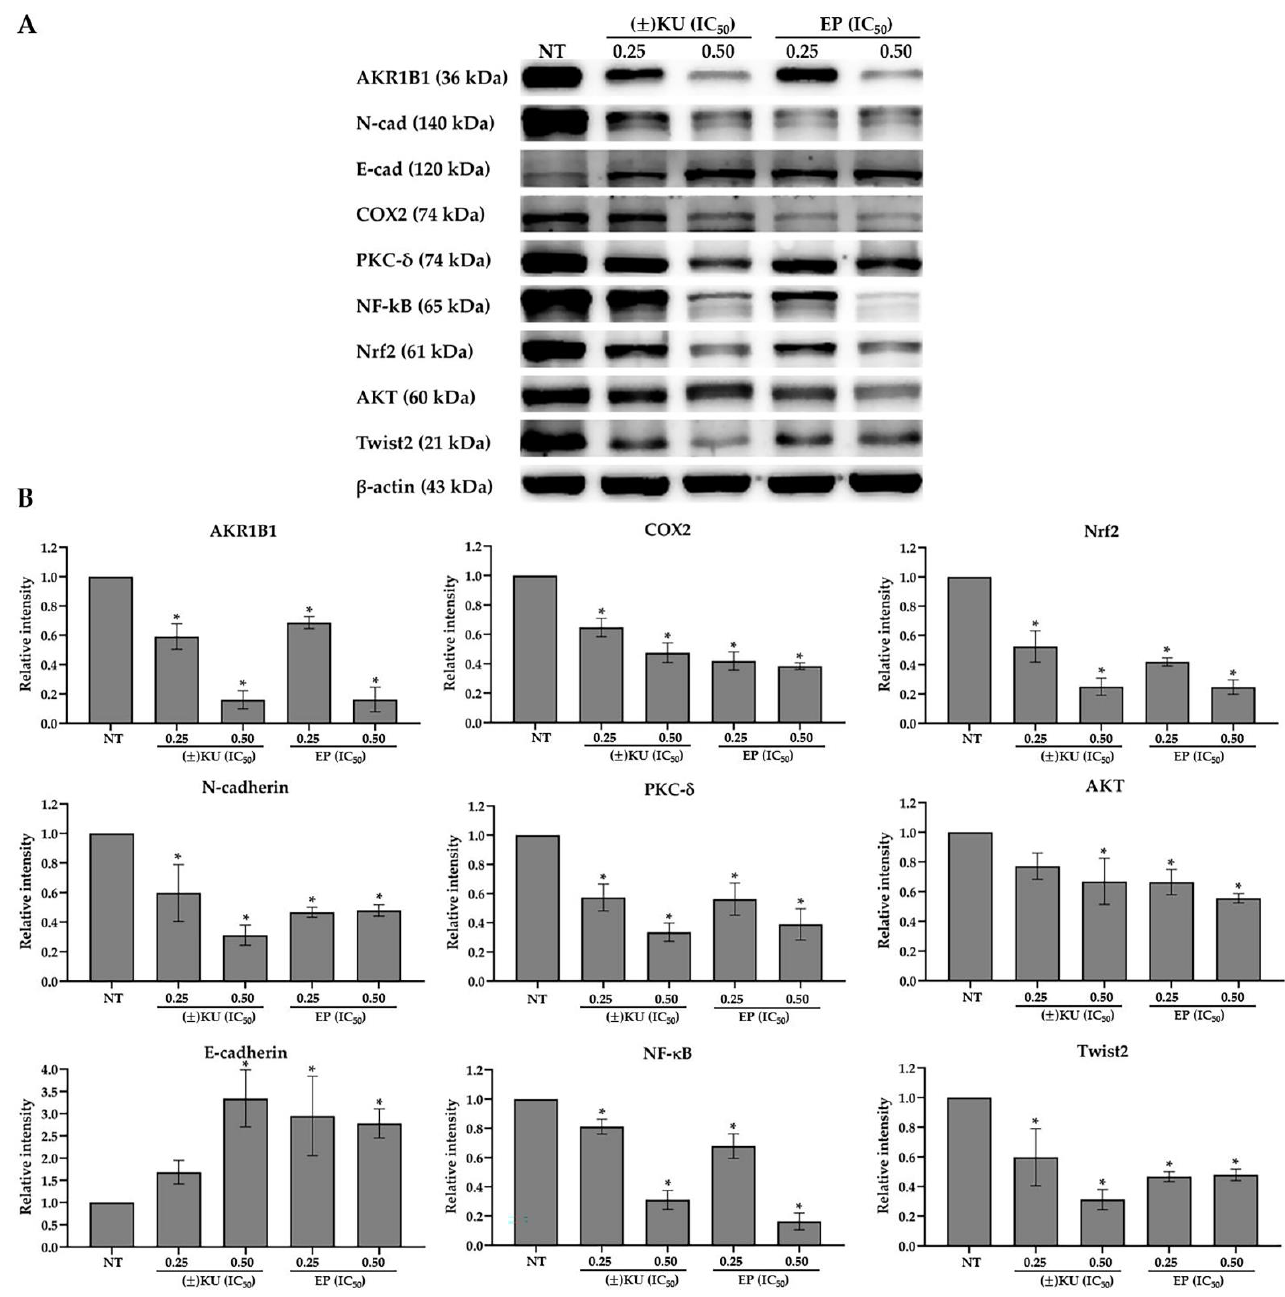
Figure 6 . Effect of ( ± ) KU on AKR1B1 and its downstream signaling molecules . Hs578T cells were Figure 6. Effect of ( ± )KU on AKR1B1 and its downstream signaling molecules. Hs578T cells treated with ( ± ) KU and EP at a concentration of 0 . 25× and 0 . 50× IC 50 ( 1 . 40, 2 .79 μ M for ( ± ) KU and were treated with ( ± )KU and EP at a concentration of 0.25 × and 0.50 × IC 50 (1.40, 2.79 µ M for 24 . 02, 48 .04 μ M for EP, respectively ) for 48 h . ( A ) The protein level of AKR1B1 and its downstream ( ± )KU and 24.02, 48.04 µ M for EP, respectively) for 48 h. ( A ) The protein level of AKR1B1 and its molecules ( PKC δ, NF -κ B, AKT, Nrf2, COX2, Twist2, E - cadherin and N - cadherin ) were determined downstream molecules (PKC δ , NF- κ B, AKT, Nrf2, COX2, Twist2, E-cadherin and N-cadherin) were by Western blot analysis . ( B ) Quantitative protein level of AKR1B1 and its downstream molecules determined by Western blot analysis. ( B ) Quantitative protein level of AKR1B1 and its downstream were normalized with β- actin band intensity . Data are represented as mean ± SD with three inde- pendent experiments . Statistically significant differences between treated cells and non-treated cells molecules were normalized with β -actin band intensity. Data are represented as mean ± SD with three independent experiments. Statistically significant differences between treated cells and non- treated cells were determined by a one-way analysis of variance, followed by Tukey’s multiple comparison test (* p < 0.05). NT, non-treated cells; ( ± )KU, trans -( ± )-kusunokinin; EP,